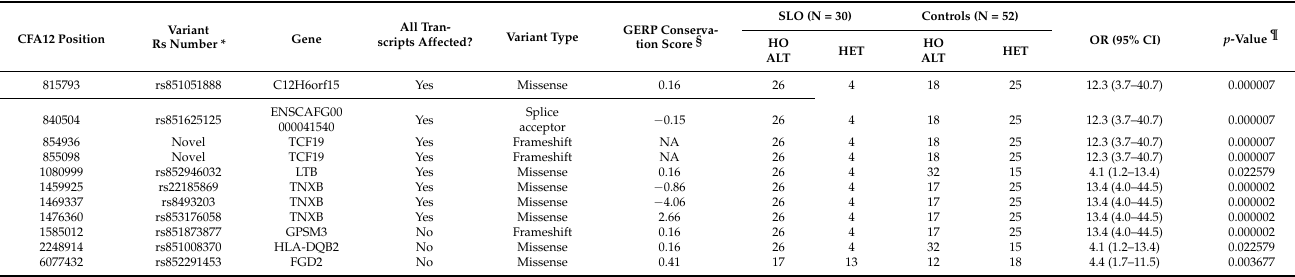
Table 1. Variants of interest selected for further exploration on canine chromosome (CFA) 12. Odds ratio (OR) calculated for the homozygous non-reference genotype in 82 unrelated Bearded Collies (30 SLO, 52 controls). Locations are based on the CanFam3.1 reference genome.